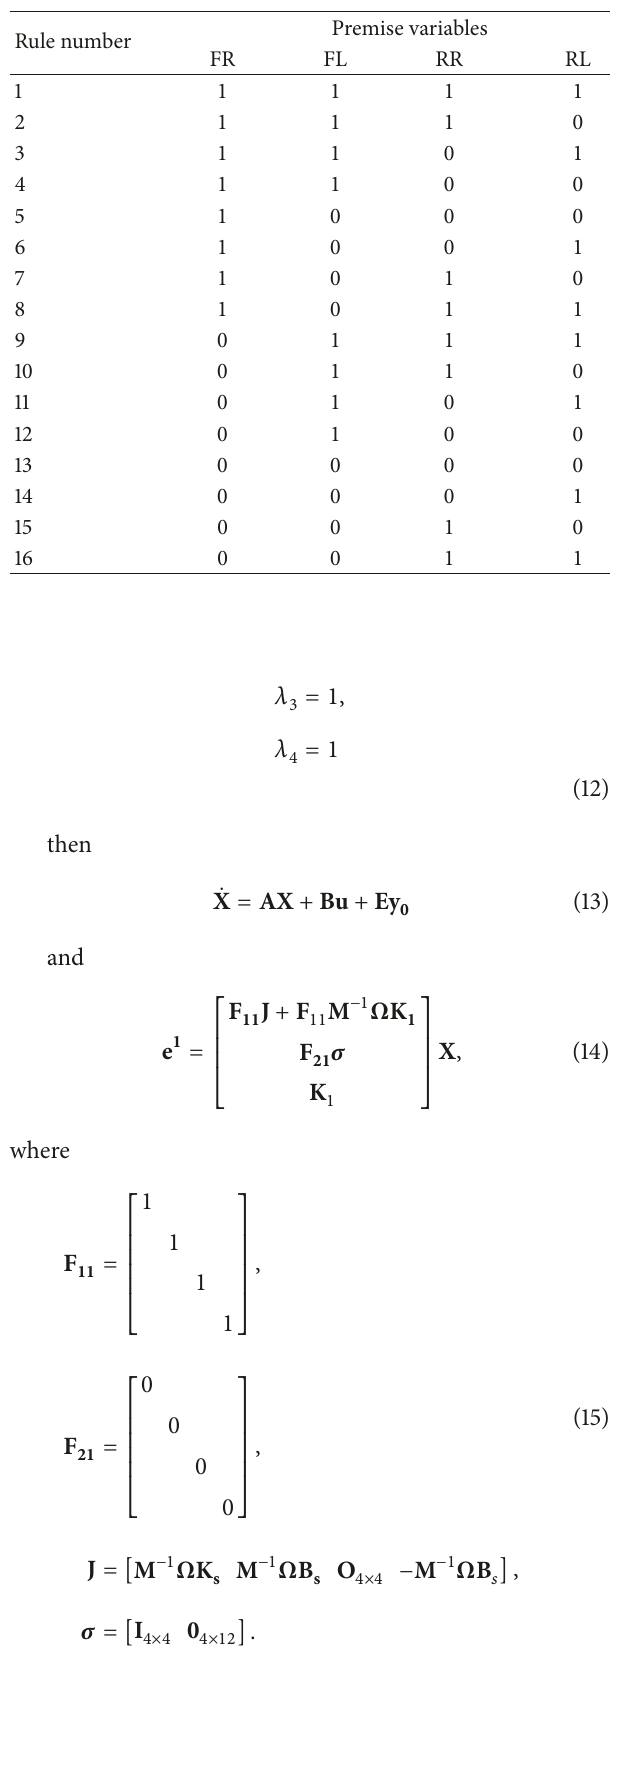
Table 1: List of fuzzy